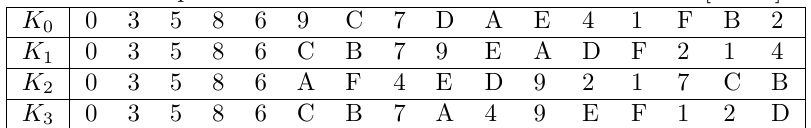
Table 13: Representatives for all 4 classes of Golden S-boxes [Saa11]